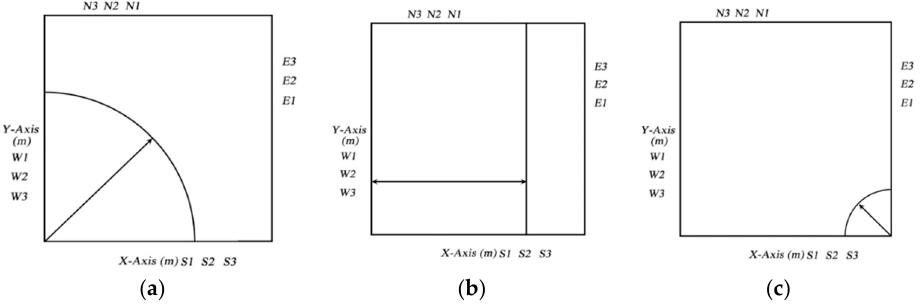
Figure 3. Potential trajectories of vehicles. ( a ) Turn left from S1; ( b ) go straight from S2; ( c ) turn right from S3.